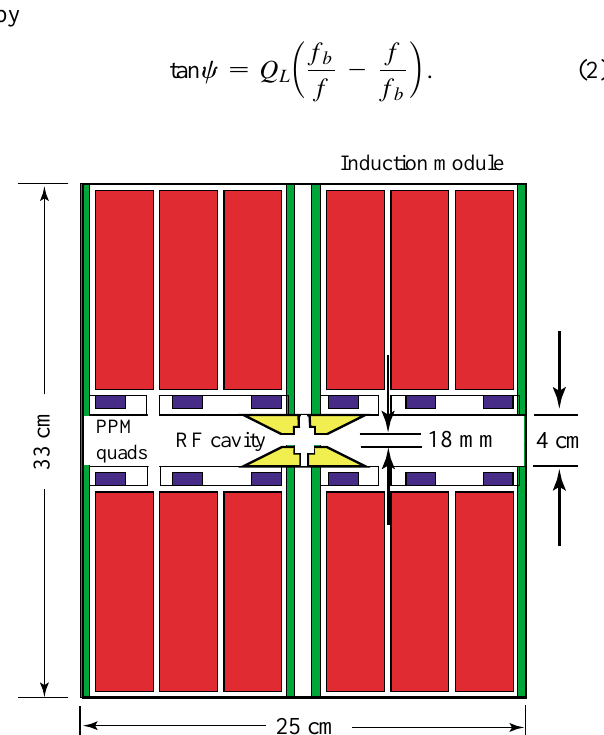
FIG. 4. (Color) One period of the main TBA extraction section, containing a single rf output structure, two induction reaccel- eration modules, and six pure-permanent-magnet quadrupoles. The beam propagates from left to right across the center of this